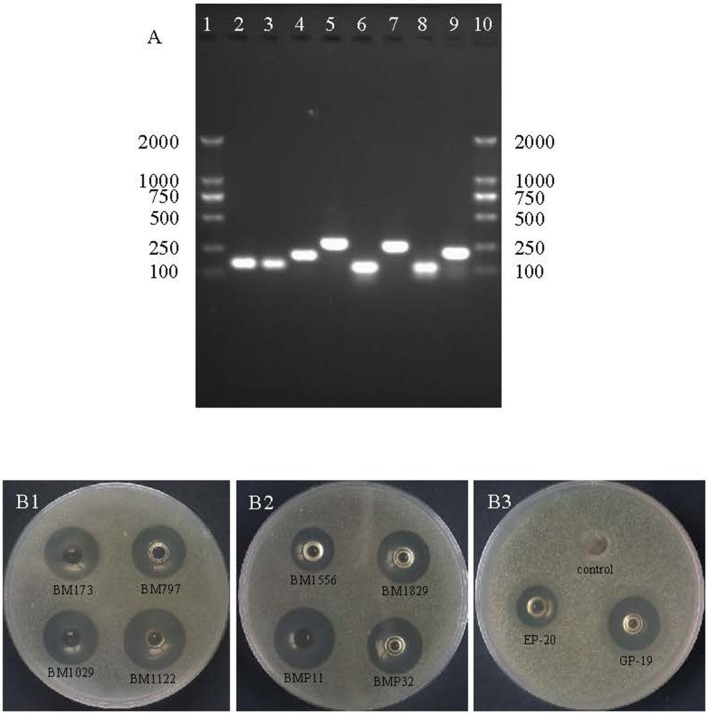
DNA agarose gel electrophoresis of PCR products of 8 hypothetical bacteriocins and inhibition zones against S. aureus ATCC29213. (A) Lane 1 and 10 are DNA marker (Novagen); lane 2 is gene of BM173; lane 3 is gene of BM797; lane 4 is gene of BM1029; lane 5 is gene of BM1122; lane 6 is gene of BM1556; lane 7 is gene of BM1829; lane 8 is gene of BMP11; lane 9 is gene of BMP32. (B1) Inhibition zones of BM173, BM797, BM1029, and BM1122; (B2) inhibition zones of BM1556, BM1829, BMP11, and BMP32; (B3) inhibition zones of EP-20, GP-19 and control without induction.